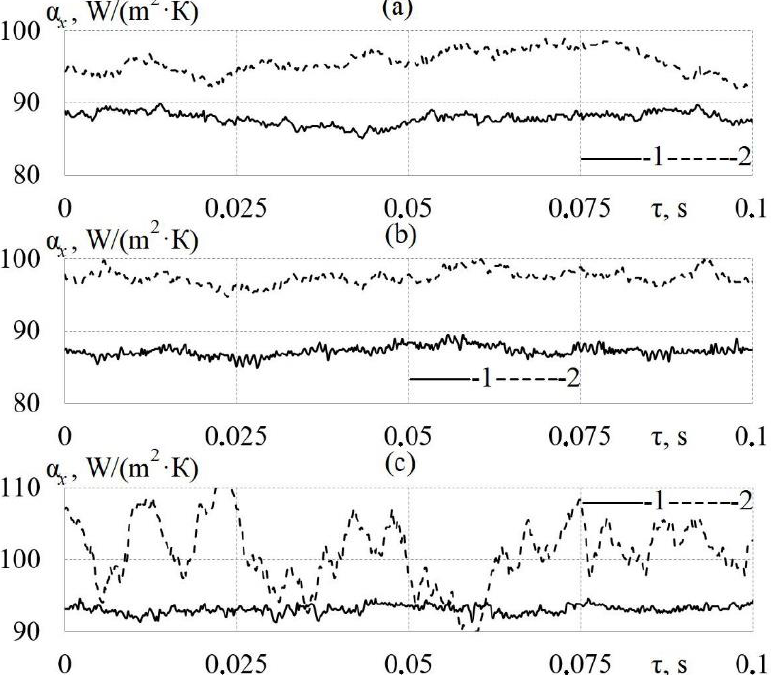
Figure 7. Dependences of the instantaneous values of the local ( l x = 100 mm) heat transfer coefficient α x over time at the flow turbulence intensity TI = 0.02 (1) and TI = 0.12 (2) in pipes with different cross-sections: ( а ) round (average rate w ≈ 13 m/s); ( b ) square ( w ≈ 13 m/s); ( c ) triangle ( w ≈ 12 m/s).